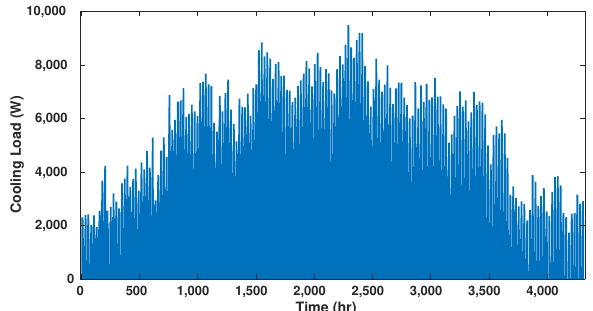
Figure 3. Hourly cooling load of single-zone